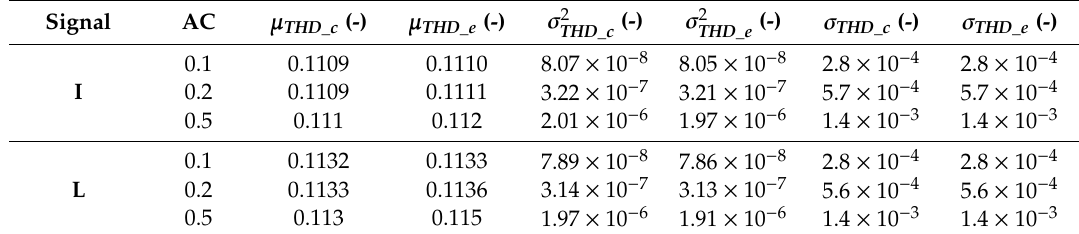
Table 12. Results of test, for signals I and L , for the 3 accuracy classes.